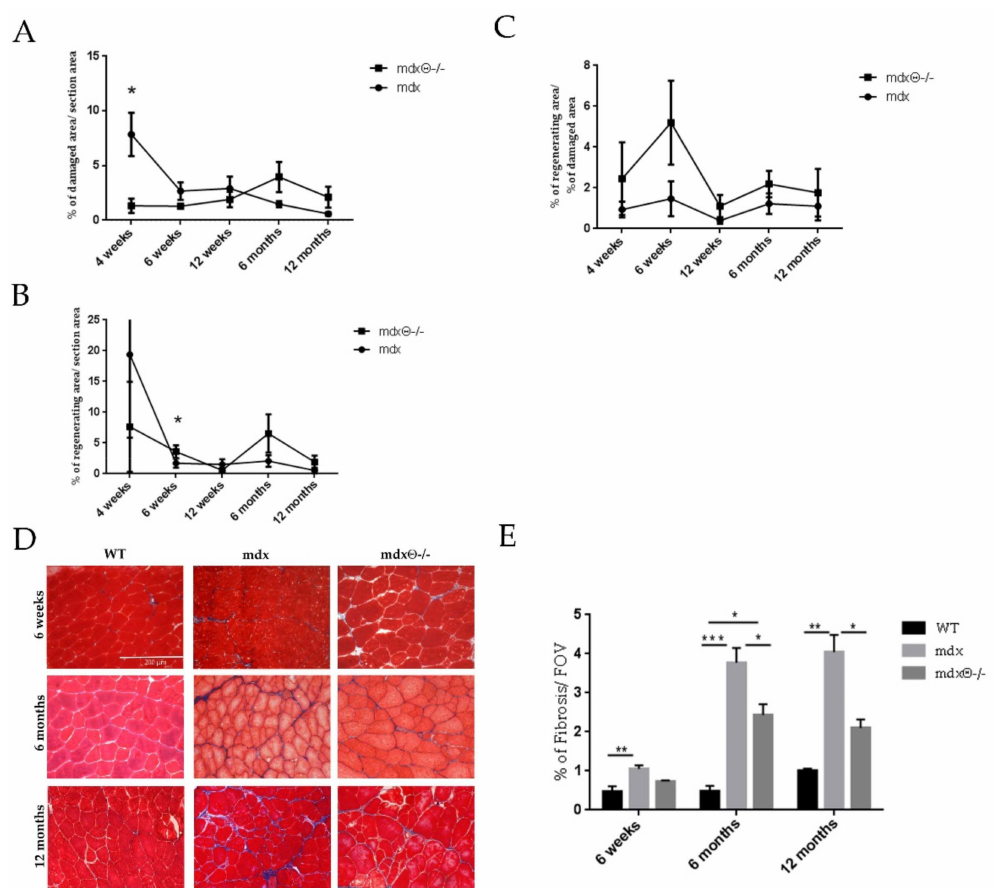
Figure 1. ( A ) Muscle degeneration level evaluated in mdx or mdx / θ − / − mice at the indicated ages, quantified as the percentage of damaged area over the total area in H&E stained TA cryosections. ( B ) Muscle regeneration as in A, quantified as the percentage of eMHC positive area over total area of TA cryosections. ( C ) Ratio of regenerating area over damaged area determined in mdx and mdx / θ − / − mice at each age evaluated. The results are mean SEM ( n = 4–5 / age / genotype); * p < 0.05 two-tailed ± Student’s t -test). ( D ) Representative images of Masson’s trichrome staining of cryosections derived from WT / bl10, mdx and mdx θ − / − TA muscle at 6 weeks, 6 and 12 months (bar = 200 µ m). ( E ) Fibrosis was quantified as the percentage of Masson’s trichrome positive area per field of view in TA section. Statistical significance was determined by a one-way ANOVA using a Tukey’s post-test (* p < 0.05, ** p < 0.01, *** p < 0.001 means ±